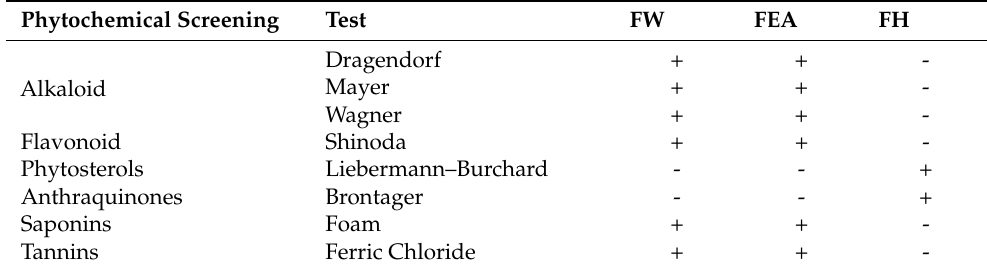
Table 2. Phytochemical screening of FW, FEA, and FH of Noni fruit. Phytochemical Screening